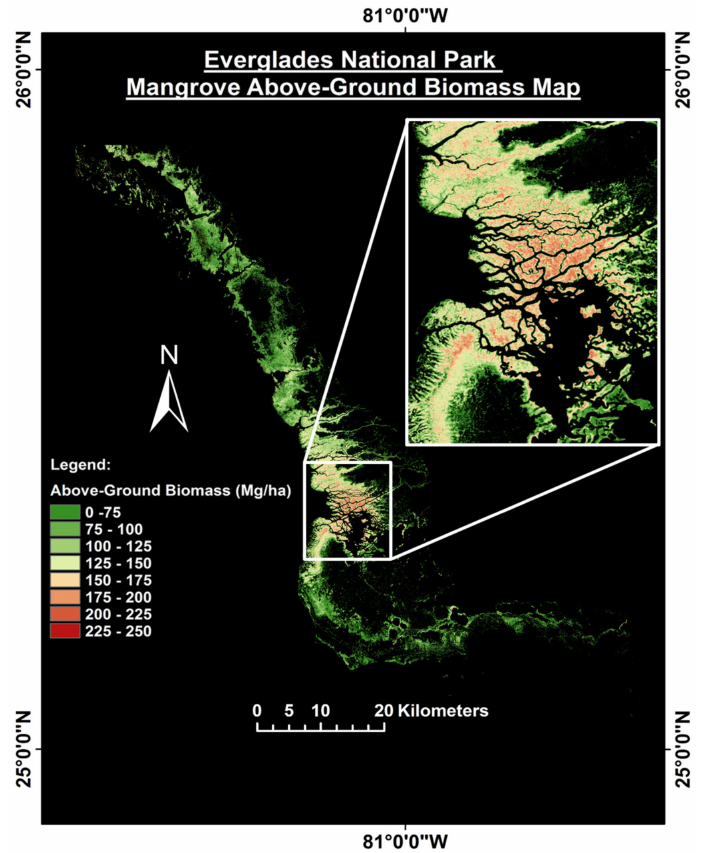
Figure 10. Everglades National Park mangrove AGB map based on TDX canopy height data and Simard et al. [3] ENP mangrove height to AGB